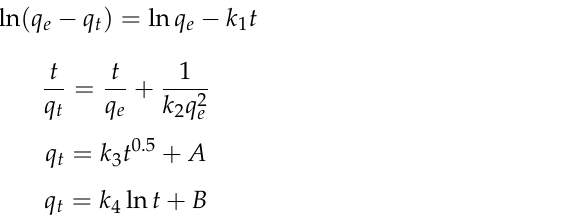
Figure 8. The adsorption performance under different initial MB concentrations.